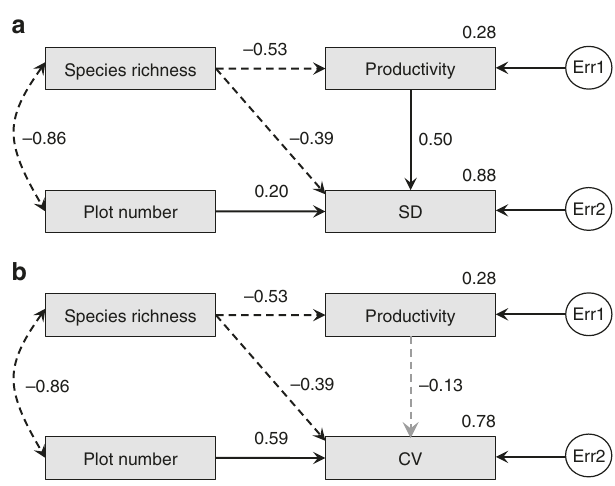
Fig. 7 Structural equation model showing the connections between biodiversity, productivity, and variability. The grouping of plots is consistent with Fig. 6 ( N = 47 plot groups). Variability was measured either as the standard deviation ( a ), or as the coef fi cient of variation ( b ) of productivity across plots within each level of species richness. Solid and dashed one- way straight black arrows represent positive and negative effects, respectively. The one-way gray arrow represents an insigni fi cant ( P > 0.05) effect. Dashed two-way black arrows represent negative correlations. To avoid zero degree of freedom, the ‘ productivity ’ variable in b was not dropped from the model. The exogenous unobserved variables err1 and err2 accounted for the unexplained errors in the estimation of productivity and productivity variability, respectively. Productivity data was ln-transformed before analyses to ensure normality. Test statistic = 0.863, with one model degree of freedom and P = 0.353 for both, indicating close model-data fi t. Standardized regression weights (along one-way arrows), correlations (along two-way arrows) and squared multiple correlations (beside Productivity, SD, and CV boxes) for the best- fi tting model are shown. Source data are provided as a Source Data fi